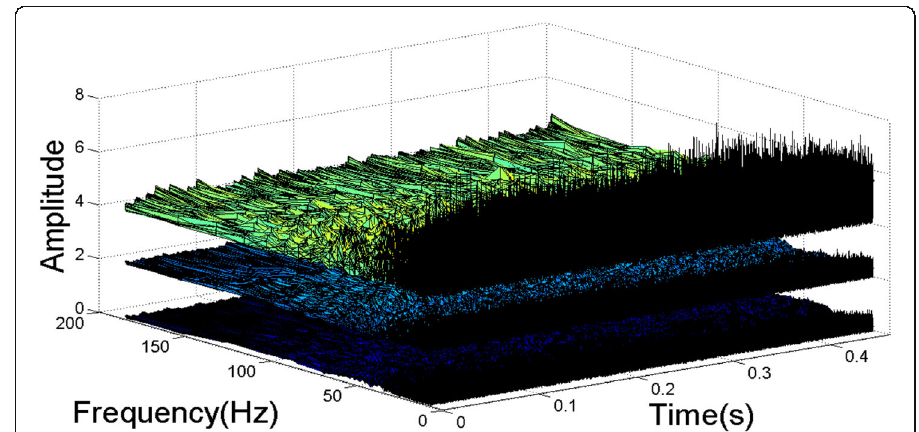
Fig. 18 Time-frequency diagrams of 3 vibration signals under fault state